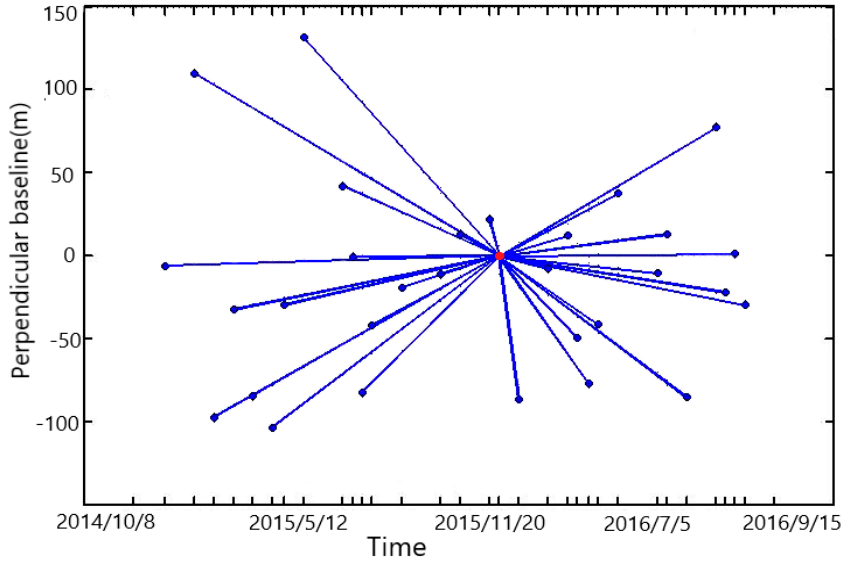
Figure 2. Baseline configurations of single-master Interferograms. The red dot indicates the master image used as a reference for each track. The blue dots represent the slave images. The blue lines connect the pairs (Interferograms). Table 1. The parameters of the Sentinel-1A SAR data (ESA, 2013).